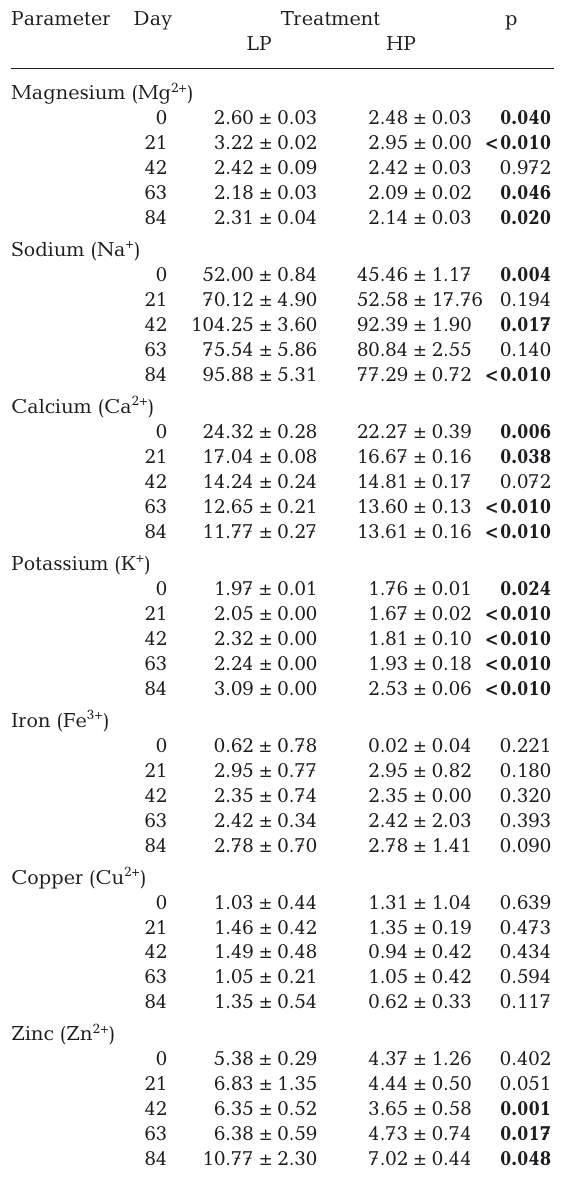
Table 5. Concentration (ppm) of inorganic cations (magne- sium, sodium, calcium, potassium) and metals (iron, copper, zinc) in tank water at each sampling event for rainbow trout Oncorhynchus mykiss fed low-phosphorus (LP) and high-